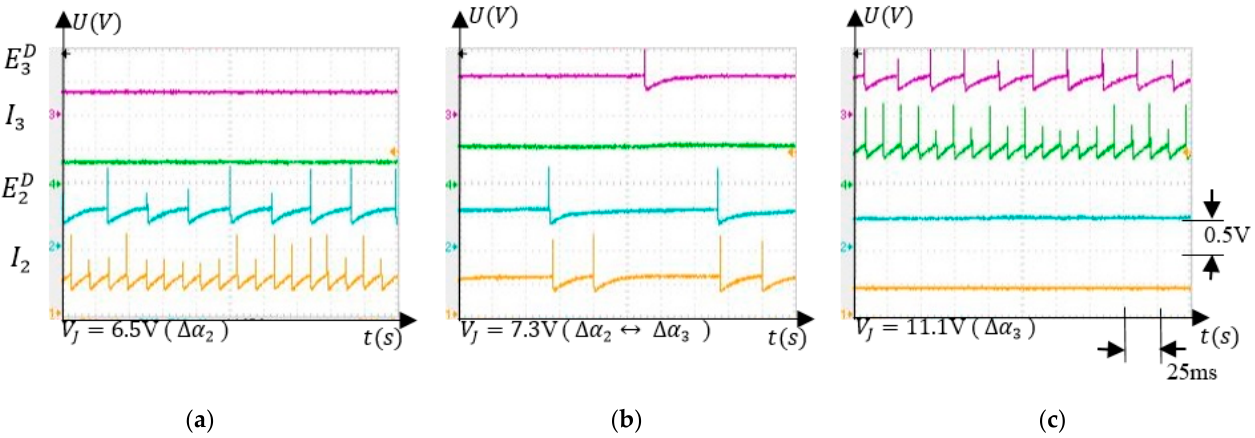
Figure 8. Neuron activity that shows the ability of the SNN to select which neural path to activate according to V J : ( a ) E D and I 2 activated when the finger is in ∆ α 2 ; ( b ) neurons from both neural paths are activated when the finger is between ∆ α 2 and ∆ α 3 ; ( c ) E D and I 3 are activated when the finger is in ∆ α 3